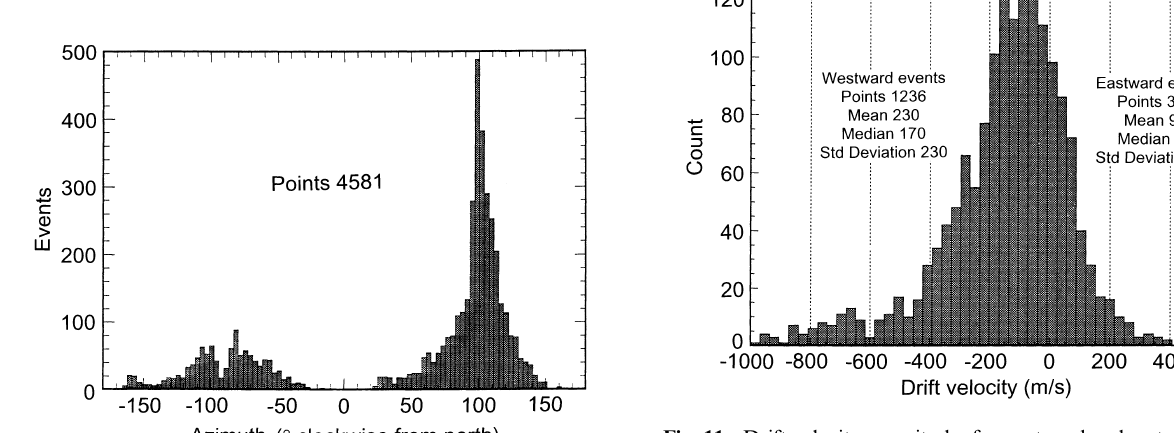
Fig. 11. Drift-velocity magnitudes for westward and eastward events. Eastward events are taken to be positive and westward events are negative. The more numerous westward-drifting events travel significantly faster than the eastward